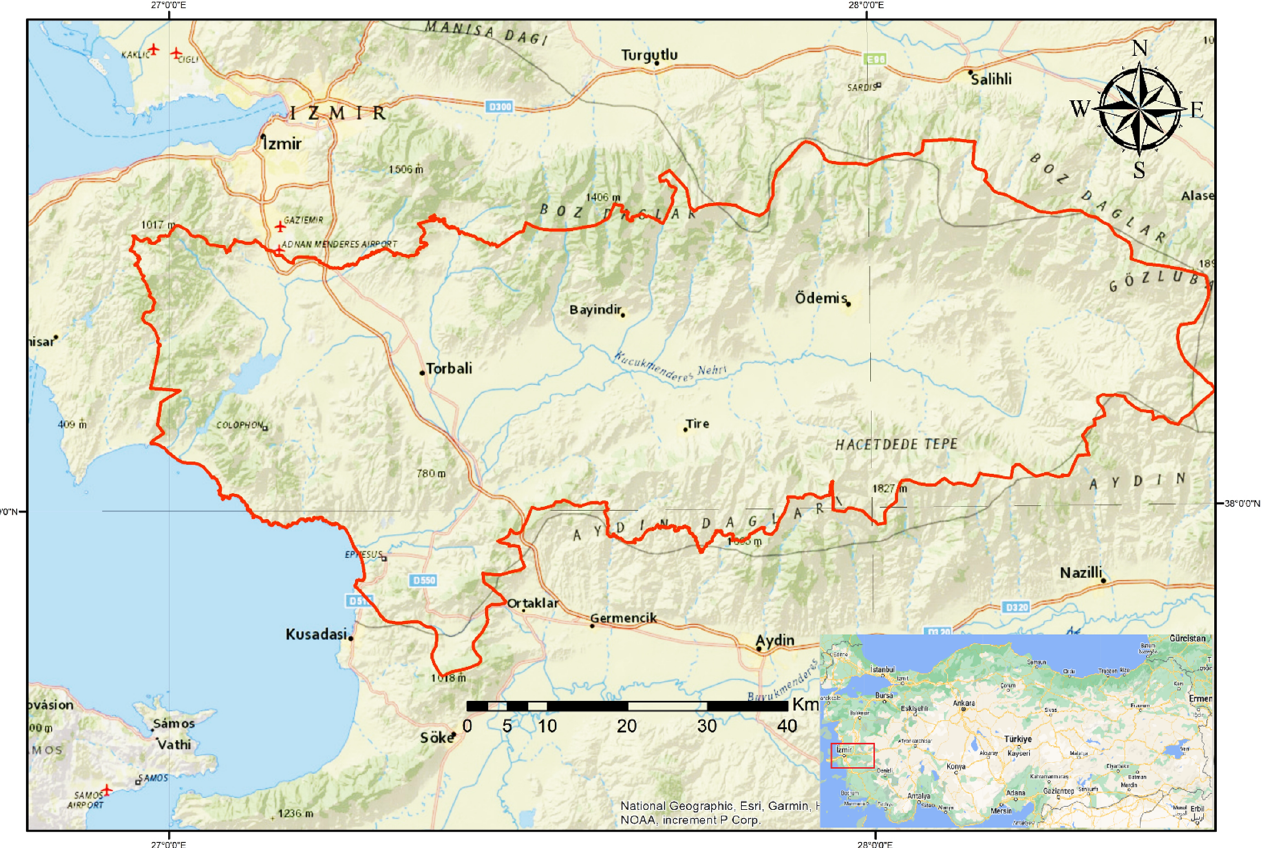
Figure 1. Map of the study area.